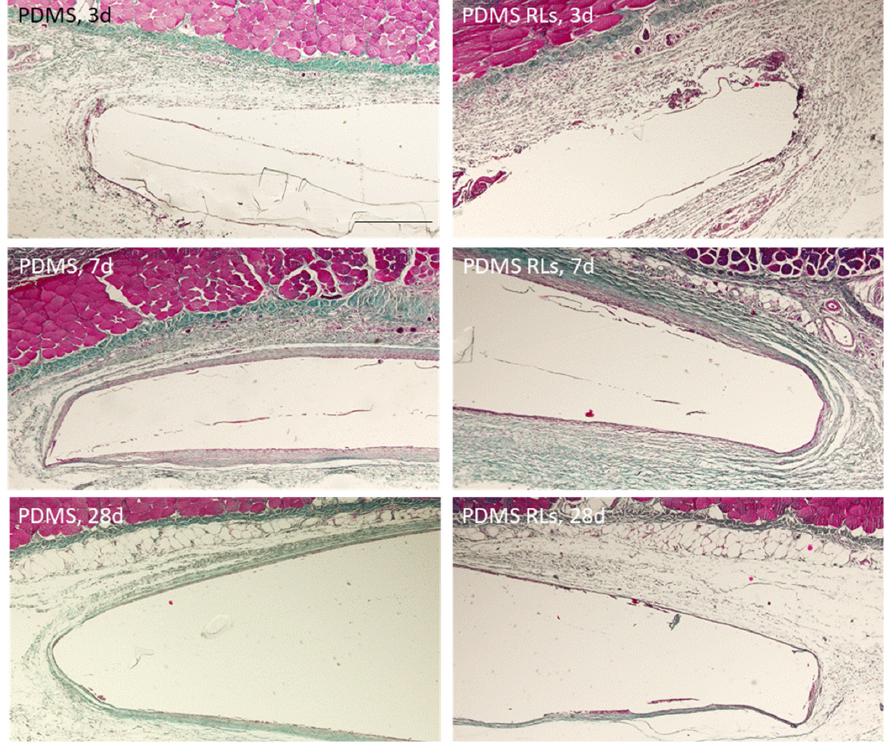
Figure 8. Representative photomicrographs of the histological tissue sections following PDMS